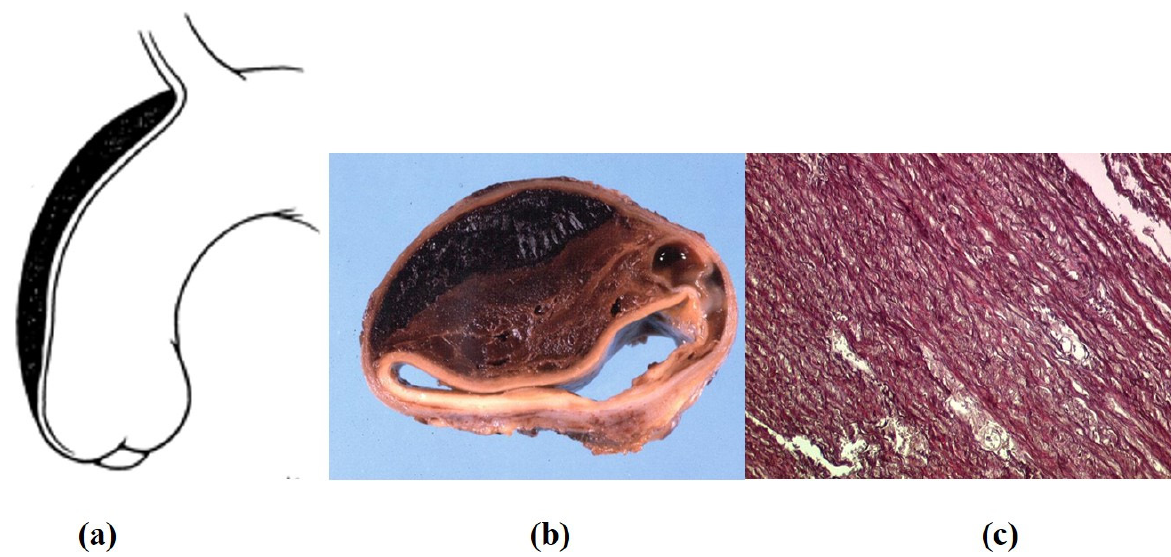
Figure 20. Intramural hematoma in the absence of intimal tear. ( a ) Schematic drawing. ( b ) Gross cross section of the aorta, with intramural hematoma. ( c ) Scattered elastic disruption. (Weigert Van Gieson stain). ( a ) Adapted from [30].